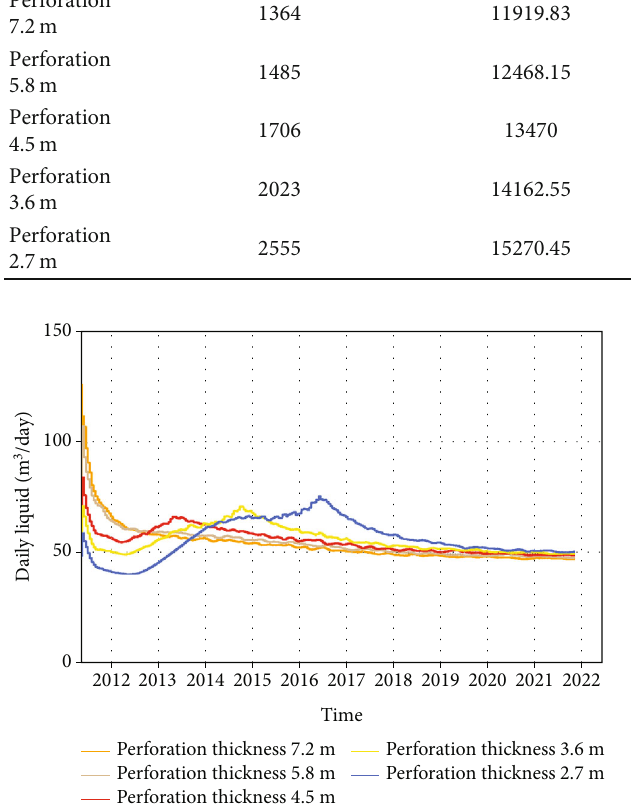
Figure 8: Daily liquid production simulated under di ff erent reservoir